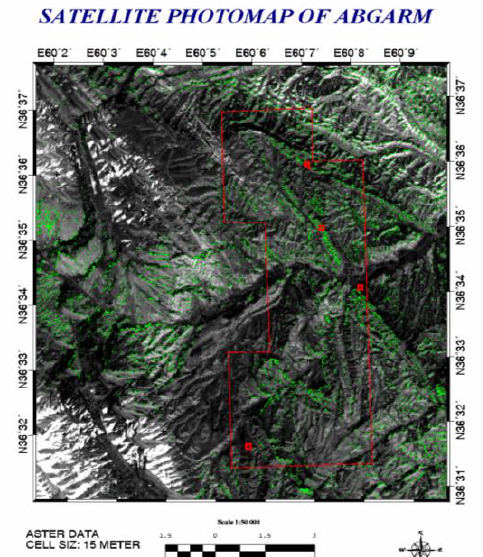
Figure 6. Spectral angle mapper (SAM) classification result for Glauconite mineral with checking point